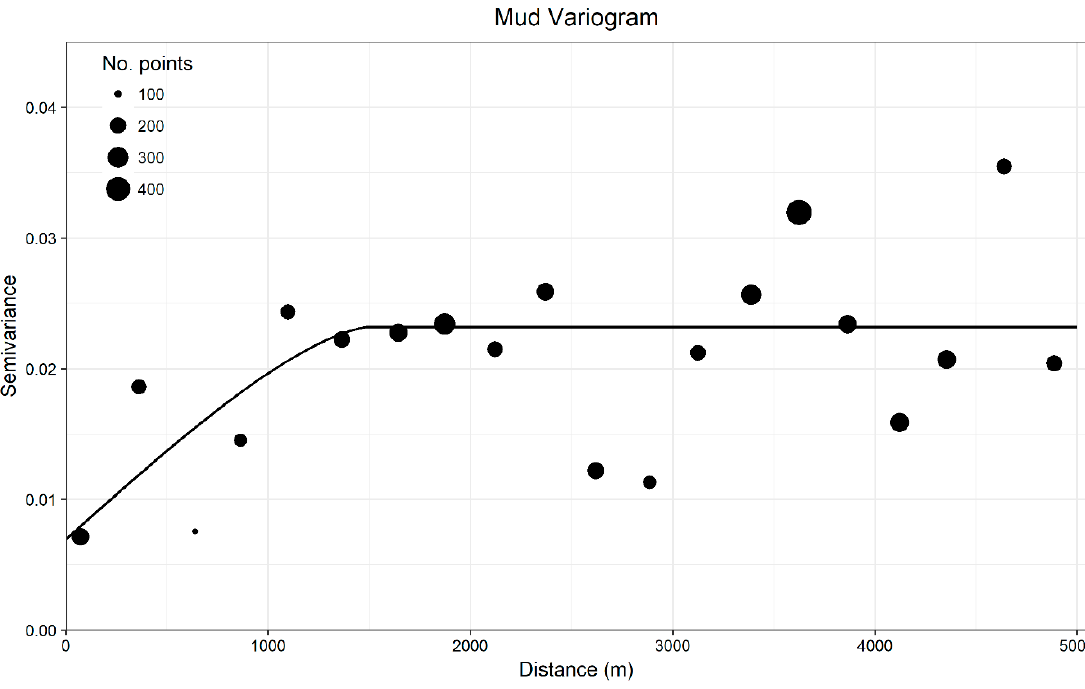
Figure A2. Sand fraction variogram circular model with 250 m lags; nugget = 0.0050, partial sill = 0.0152, major range = 1210.05 m.